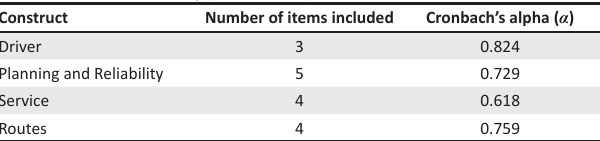
TABLE 5: Internal reliability (initial model). Construct Number of items included